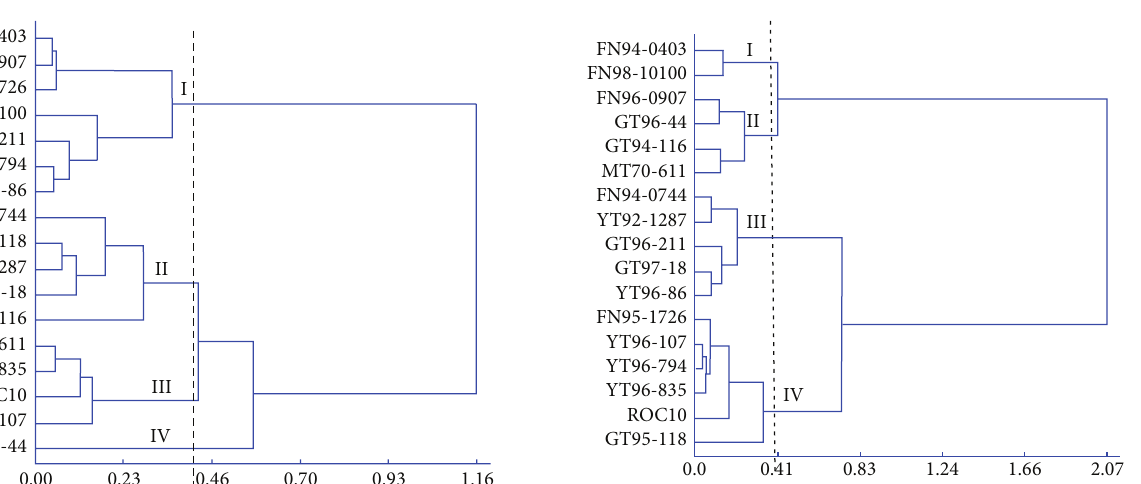
Table 6. The cumulative contribution rates of the character- istic values of the first three principal factors reached